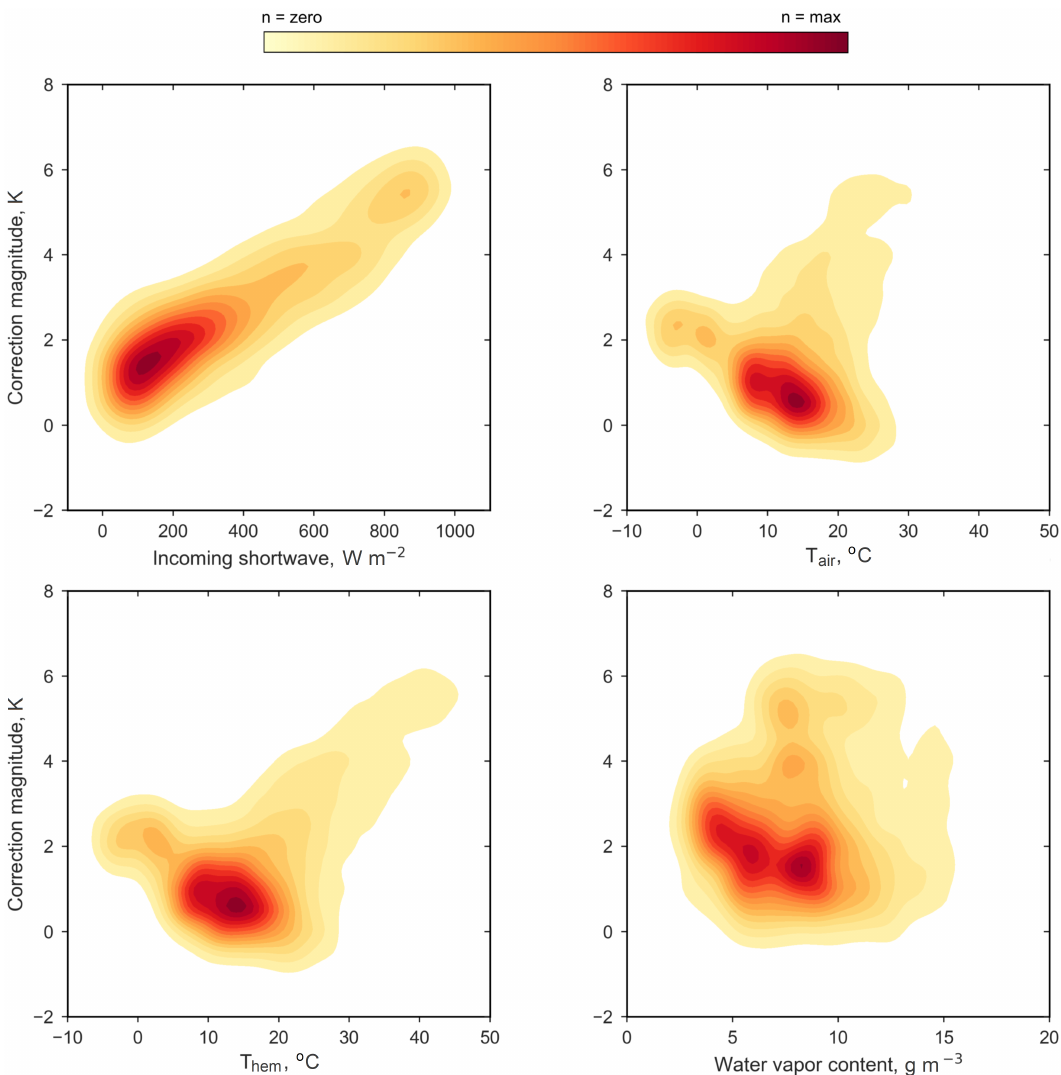
Figure 10. Correction magnitude versus incoming shortwave, T hem, r , T air , and water vapor content for the daytime hours of the study